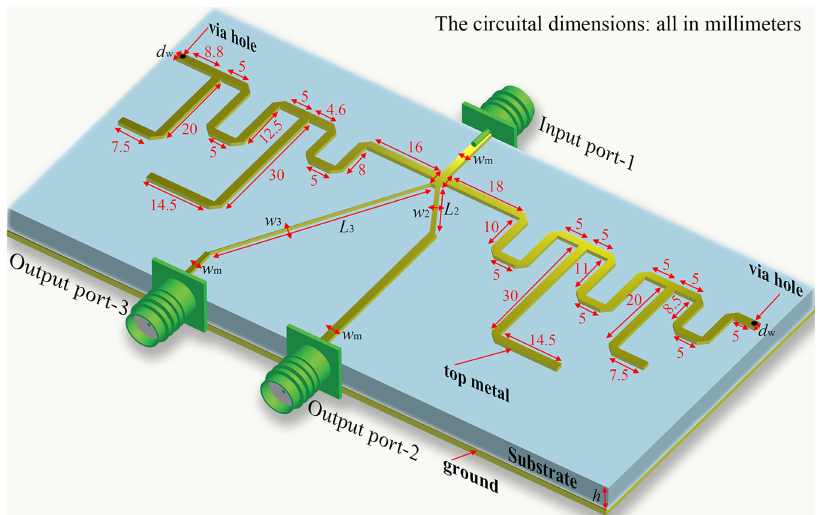
Fig 1. The three-dimensional (3D) structure of the proposed TTPD. This TTPD is excited by 50 Ω microstrip feedingline. The groundis constructed completely by a metal and the appliedsubstrate is the Rogers 4350B with the relative permittivity of 3.48, the thickness h of 0.762 mm and the loss tangent of 0.0037. The length of the FSS in output path-2 and output path-3 are marked in the picture, w m is the width of the 50 Ω microstrip feedinglines and the stubs in the FSS, w 2 and w 3 ( L 2 and L 3 ) are the width (length) of the MS in the two output paths, d w is the diameter of the via holes. w m = 1.7 mm, w 2 = 0.9 mm, w 3 = 0.1 mm, L 2 = 14.9 mm, L 3 = 48.6 mm, d w = 1.2